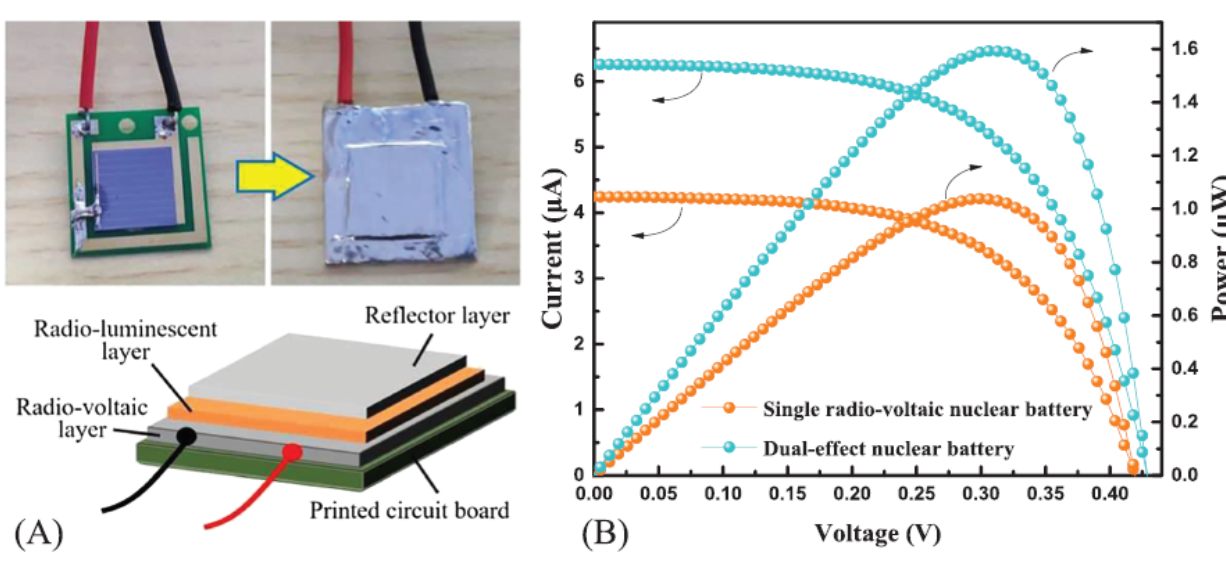
Figure 12. ( A ) Nuclear battery samples and structure schematic; ( B ) I − V and P − V characteristic curves of nuclear battery before and after performance enhancement. Copyright permission from [132].